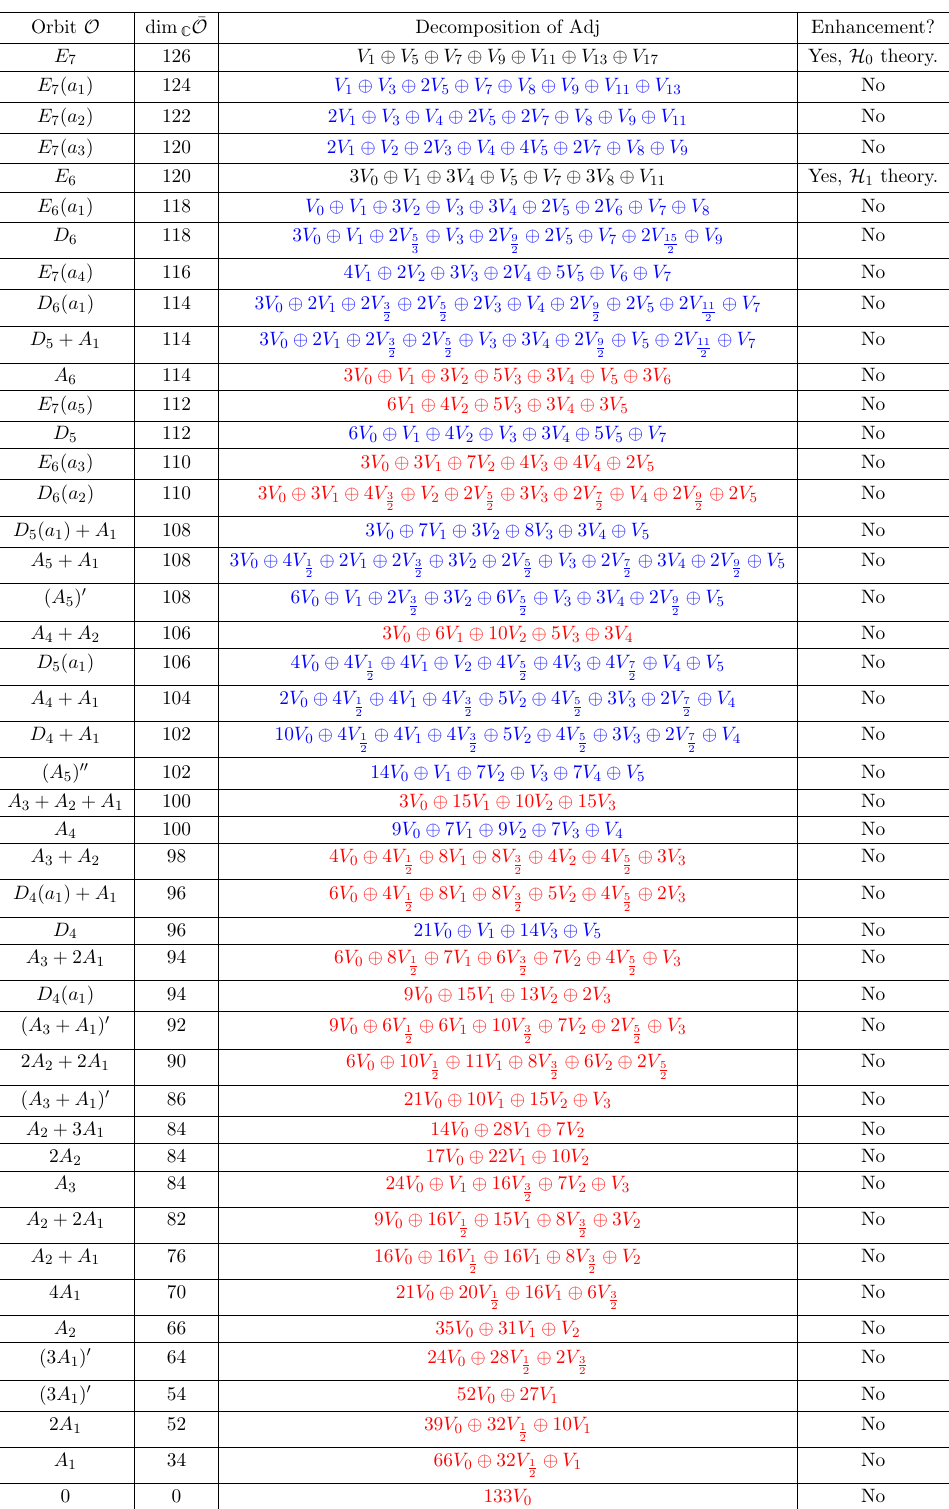
Table 4 . All the nilpotent orbits of e 7 and their adjoint decomposition. Table taken from [56].